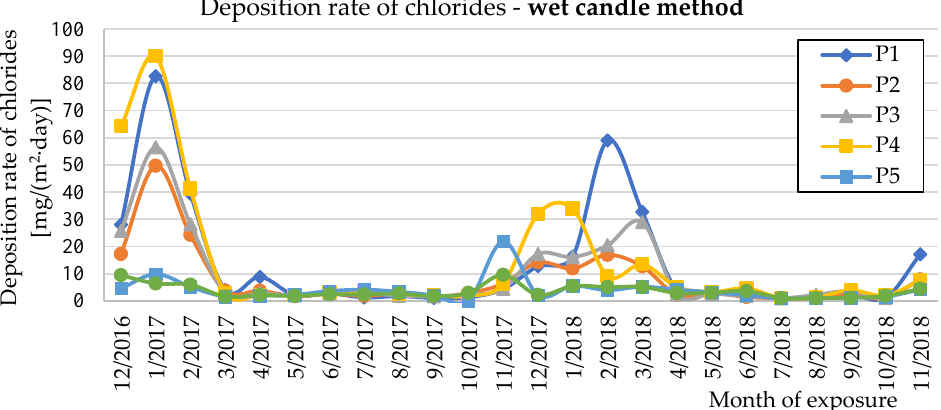
Figure 9. Deposition rates of chlorides determined by the wet candle method.